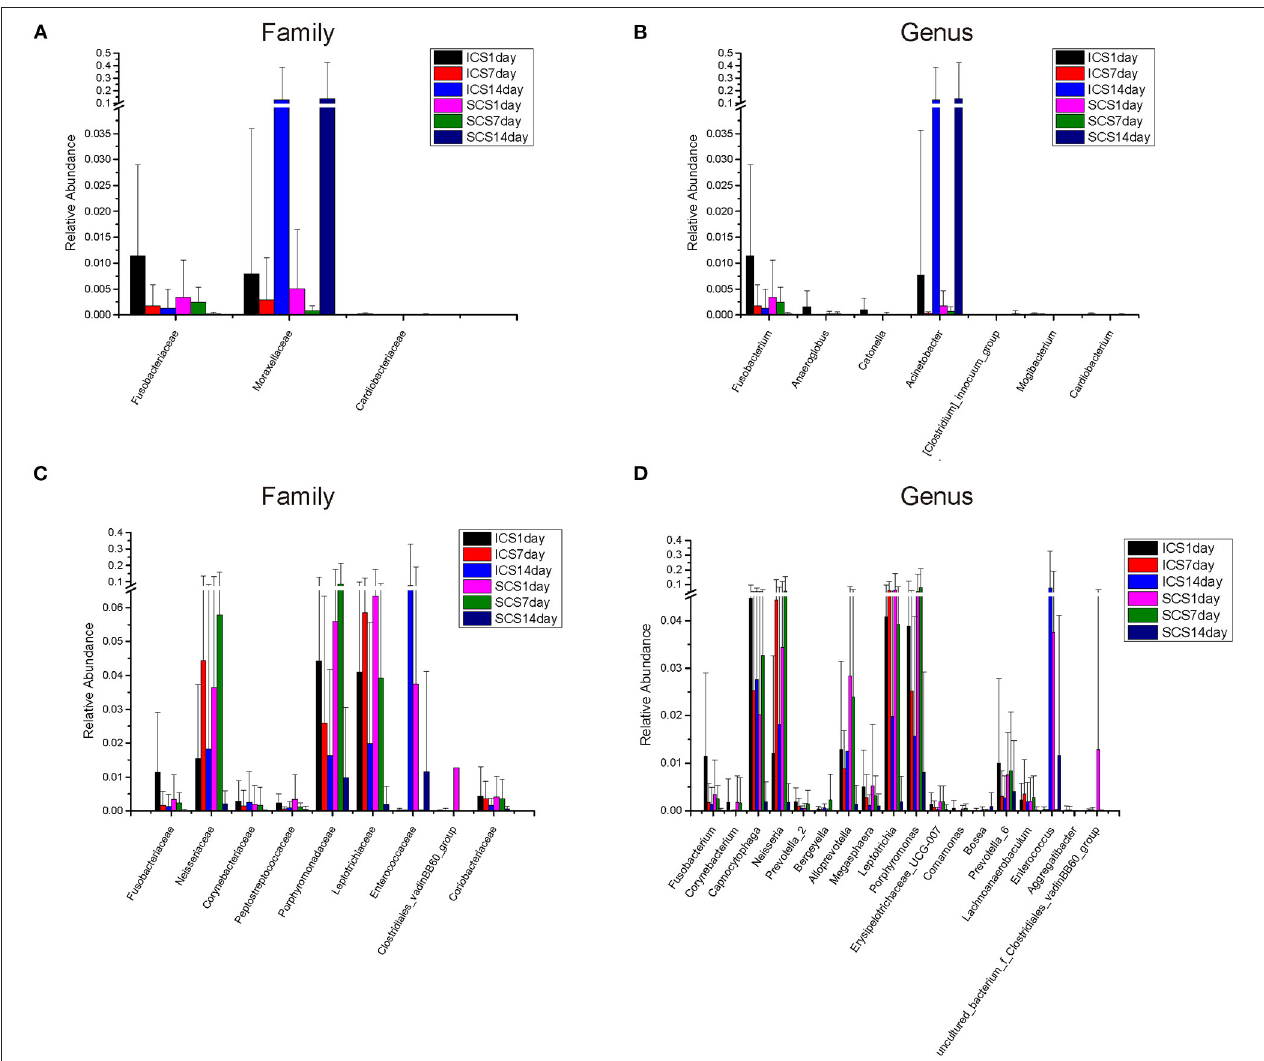
FIGURE 4 | Colonies with different abundances. (A,B) Colonies with different abundances in each group. Statistical analyses were calculated by one-way analysis of variance by ANOVA (family and genus levels, p < 0.05). (C,D) Colonies with different abundances in each group. Statistical analyses were calculated by the Wilcoxon test (family and genus levels, p <